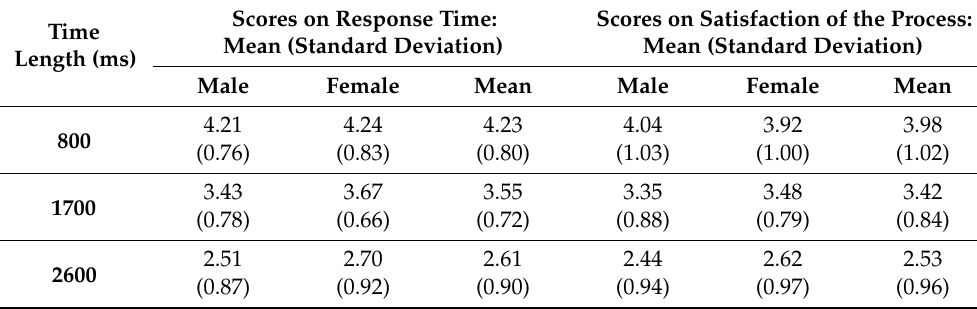
Table 3. Gender specified scores for the scenario of camera